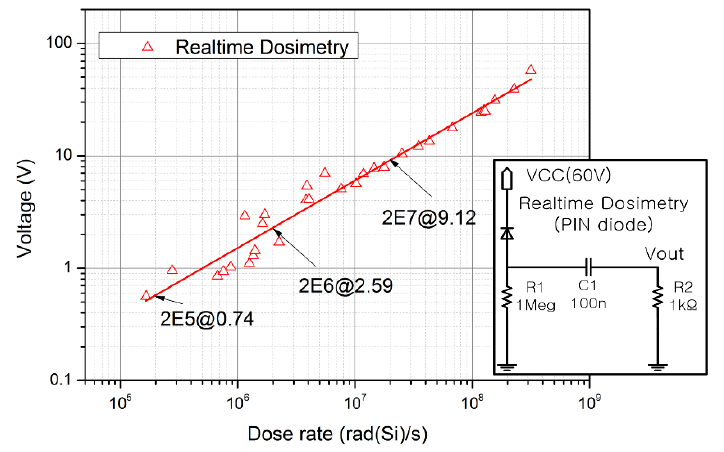
Figure 15. Output voltage measurement normalized PIN diode according to radiation dose.